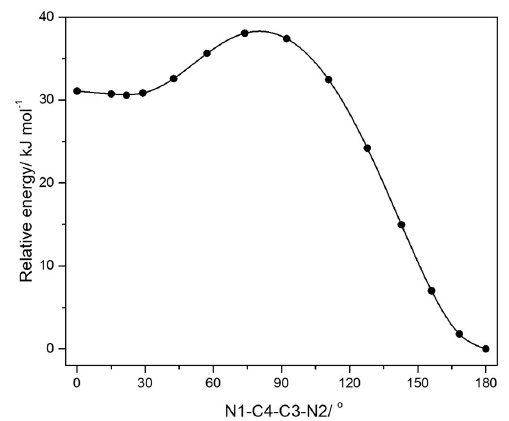
Figure 3. Potential energy profile for internal rotation about the C3-C4 inter-rings bond.